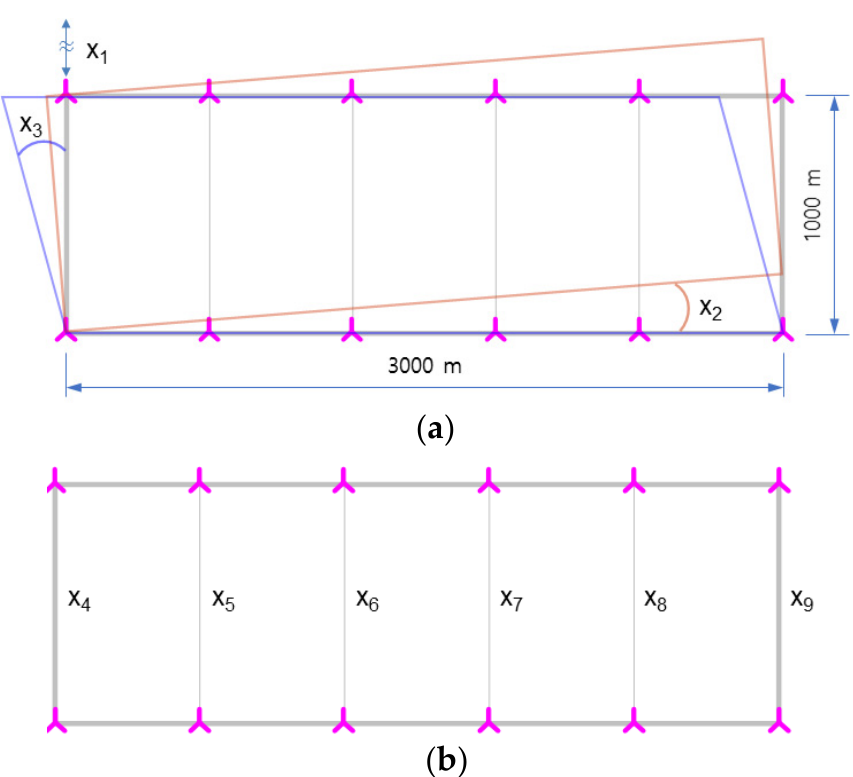
Figure 5. Design variables for offshore wind farm layout based on regular pattern (scenario 1). ( a ) Farm pattern, ( b ) Wind turbine generator column distance.